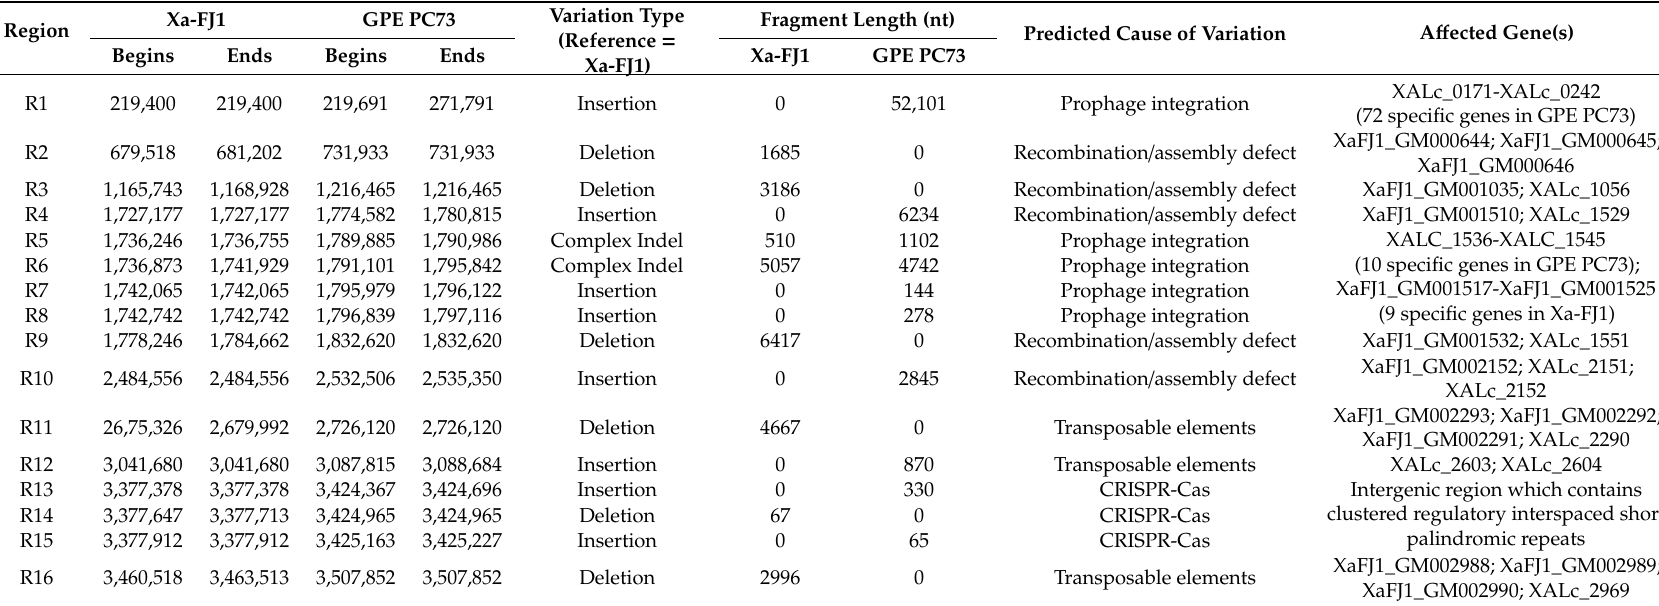
Table 2. Chromosomal structural variation between X. albilineans strains Xa-FJ1 from China and GPE PC73 from Guadeloupe (See also Figure 4).